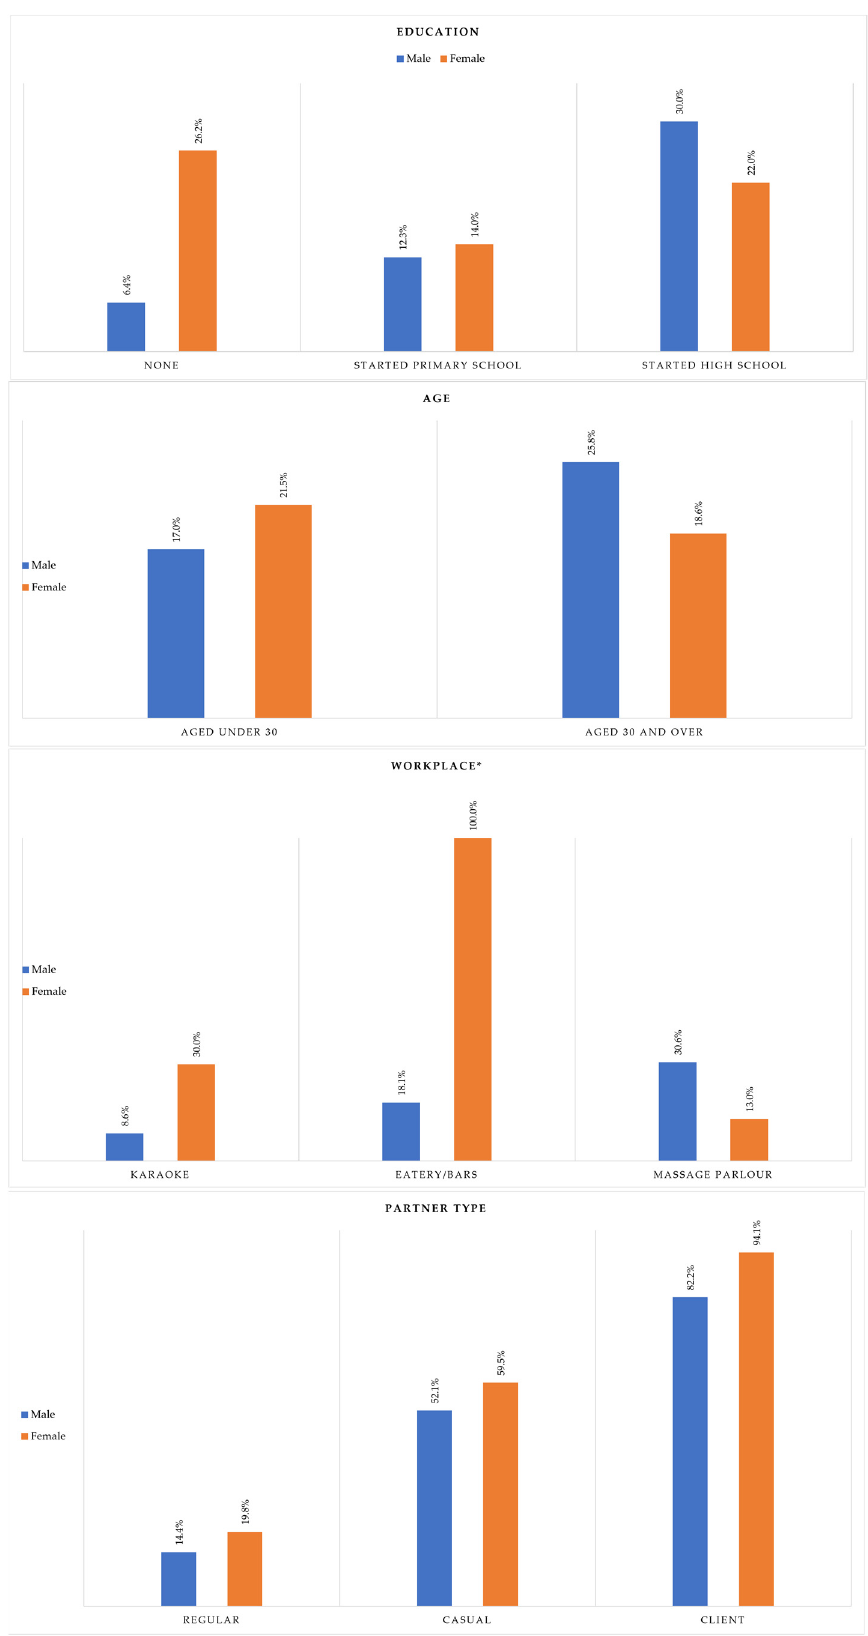
Figure 1. Relationships between consistent condom use and education, age, workplace, and partner, stratified by sex. * Note that sample size for FMSWs in eatery/bars was 1.